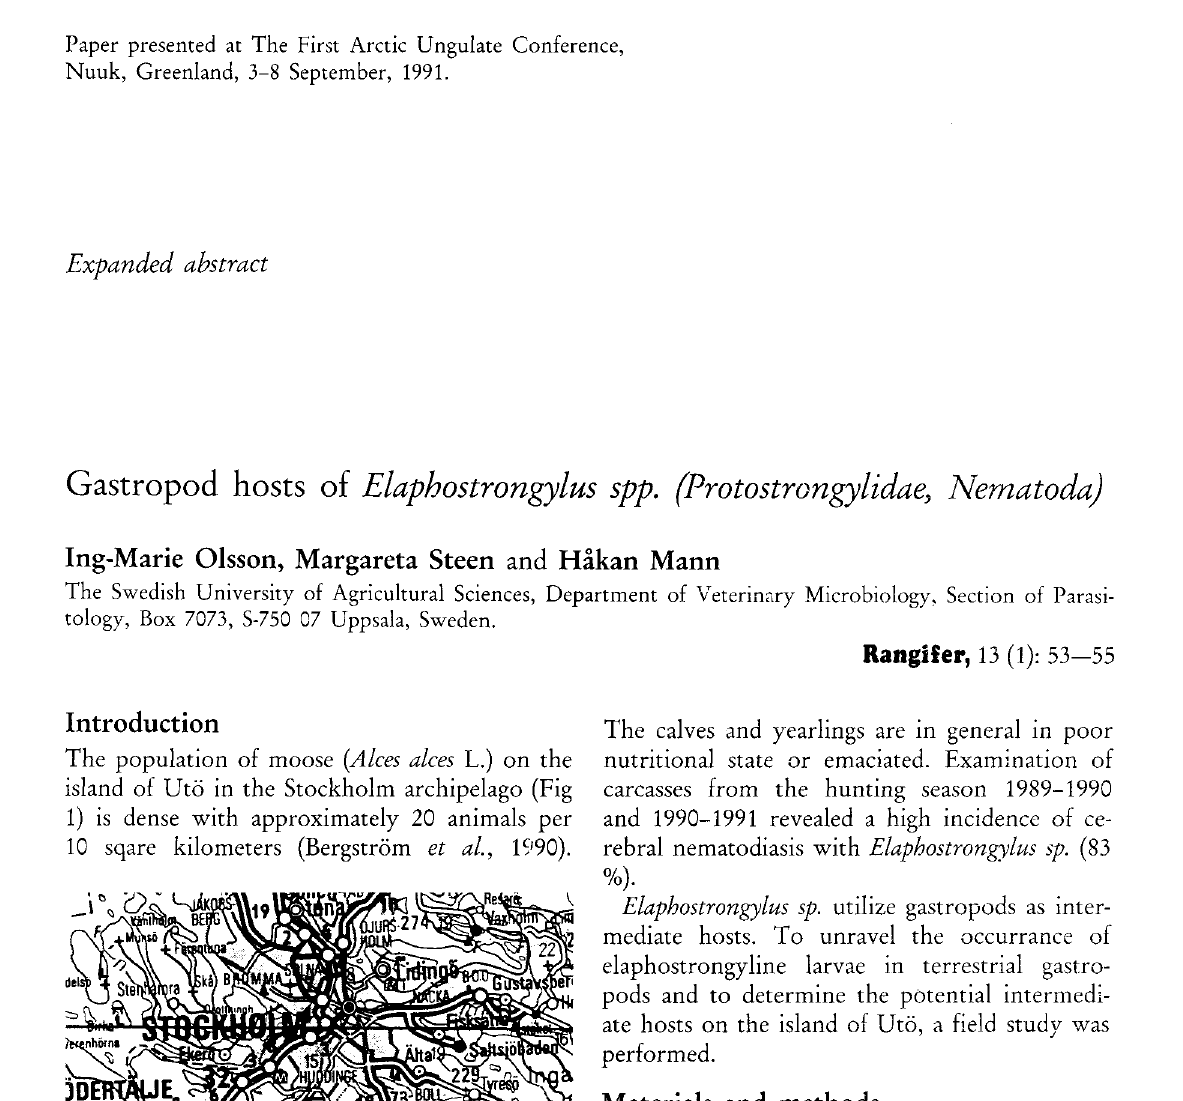
Table 1. Biotopes investigated, each sampling